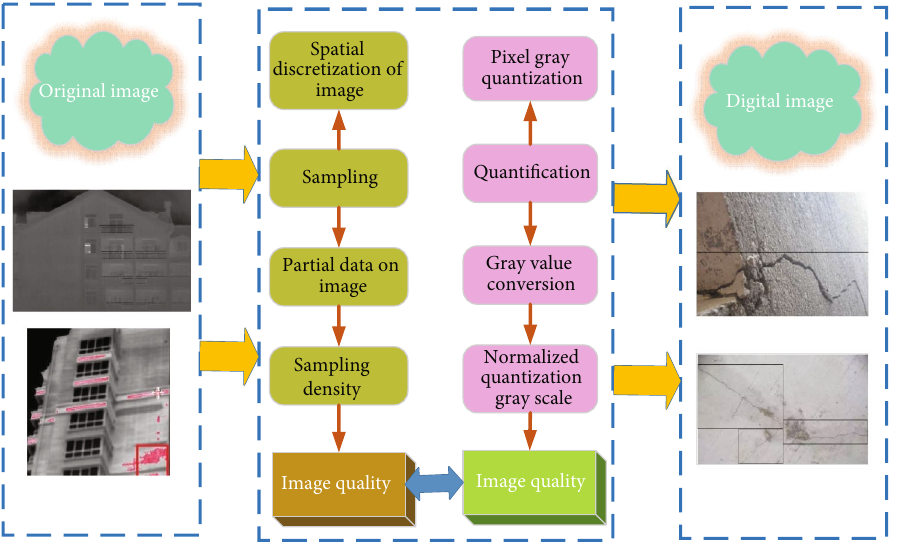
Figure 1: Speci fi c process of digital